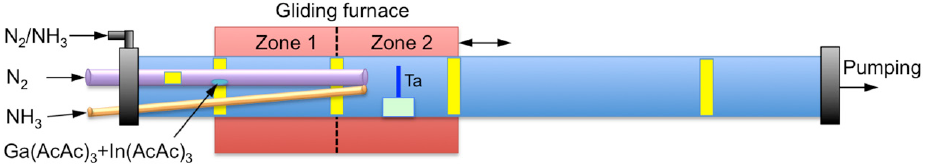
Figure 1. Schematic diagram of the CVD growth apparatus.